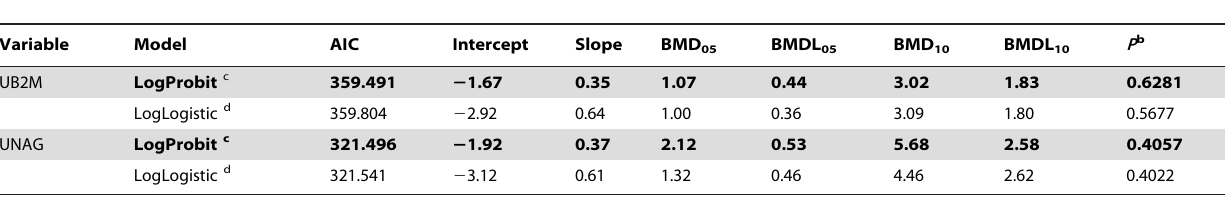
Table 6. BMD estimates of UCd ( m g/g cr) based on UB2M ( m g/g cr) and UNAG (U/g cr) by conducting BMD approach with dichotomous data of all subjects a